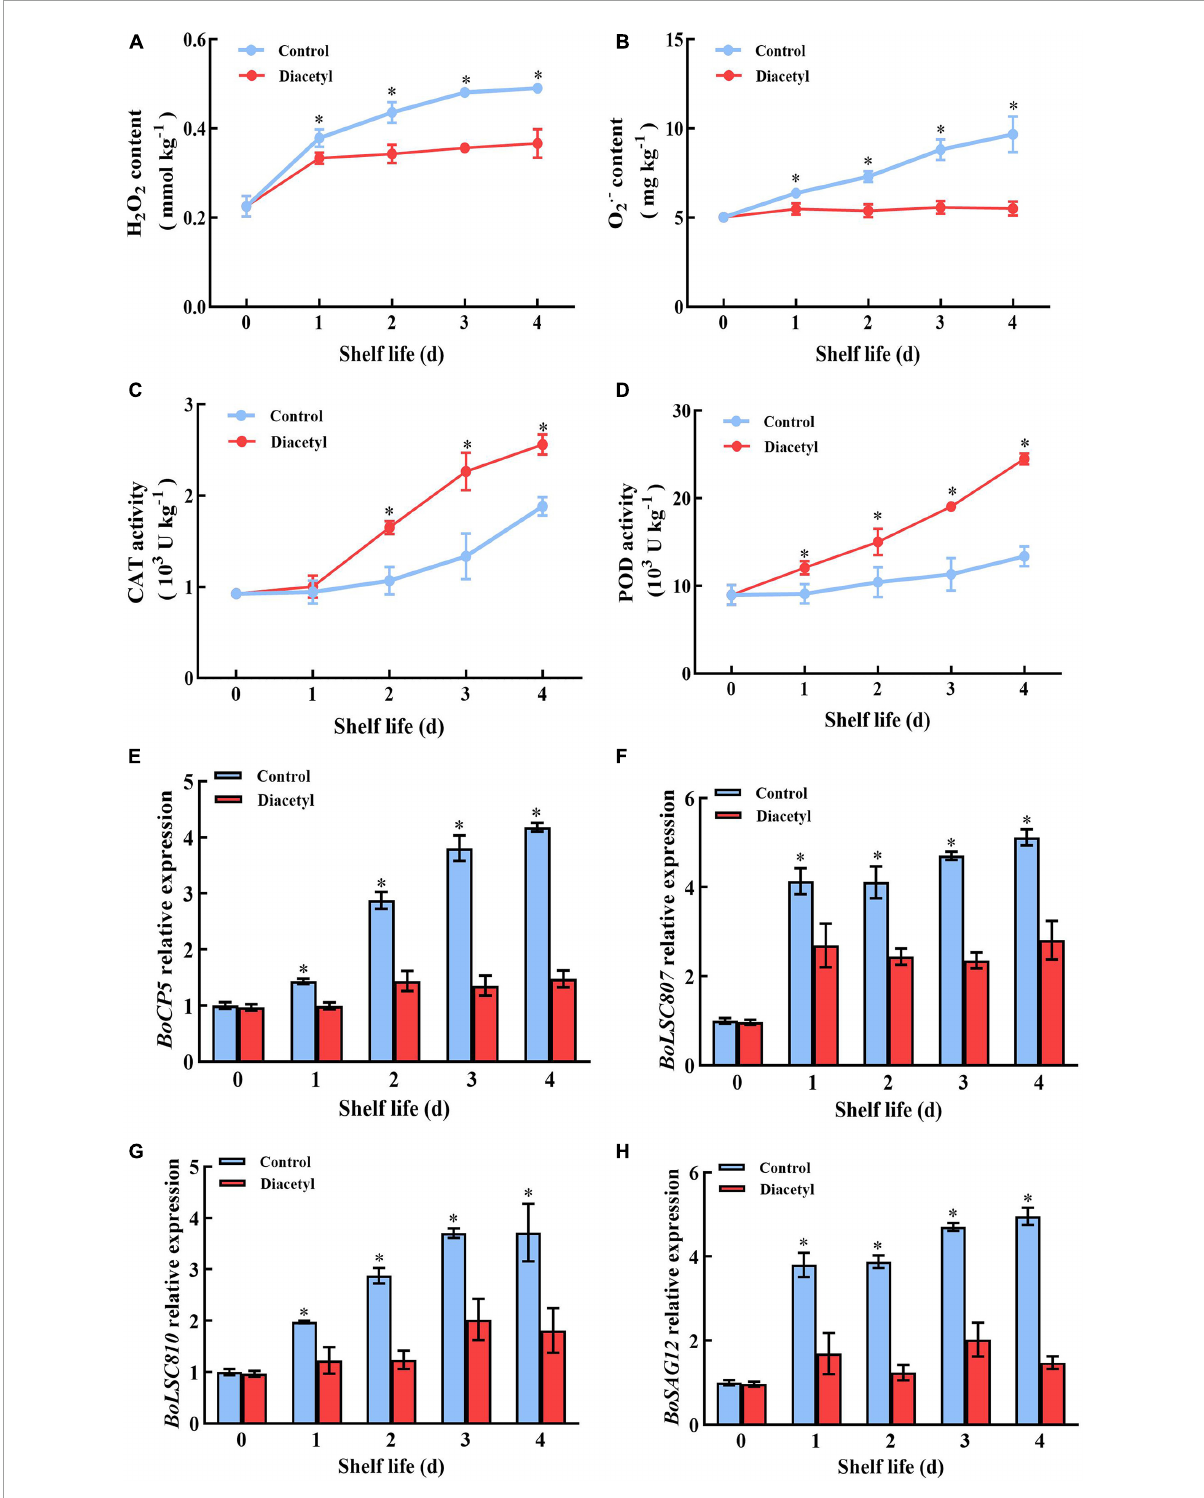
FIGURE4 Diacetyl treatment inhibited the accumulation of ROS and the transcription level of senescence-associated genes in broccoli florets. H 2 O 2 content (A) , O 2 − content (B) and the enzyme activities of POD (C) and CAT (D) . Relative expression of BoCP5 (E) , BoLSC807 (F) , BoLSC810 (G) and BoSAG12 (H) . Data are the average of three replicates ± SD. Asterisk ( ∗ ) indicates a significant difference among the control and diacetyl treatment groups at the same time at P <